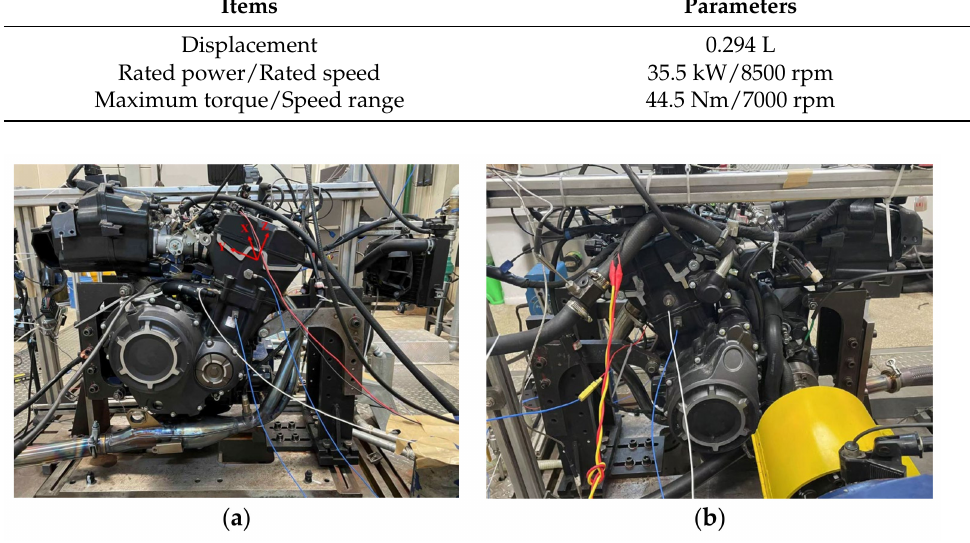
Figure 15. Sensor positions and coordinate direction of the engine. ( a ) Position of sensor 1Y. ( b ) Position of sensor 2X. Table 10. Fault type and degree parameter